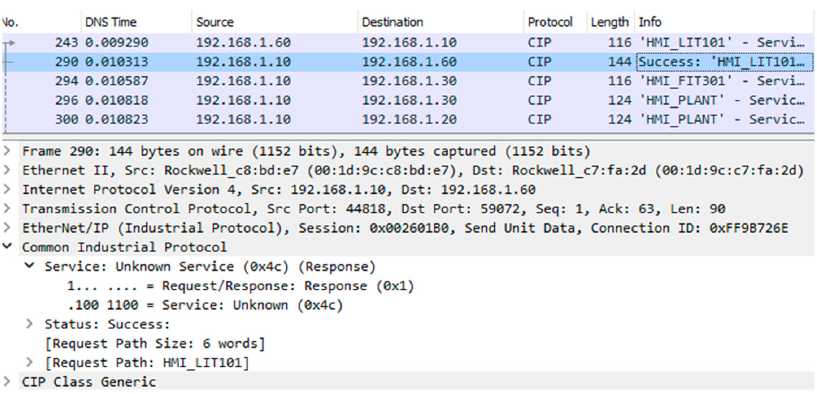
Figure 9 . Response Packet in CIP.